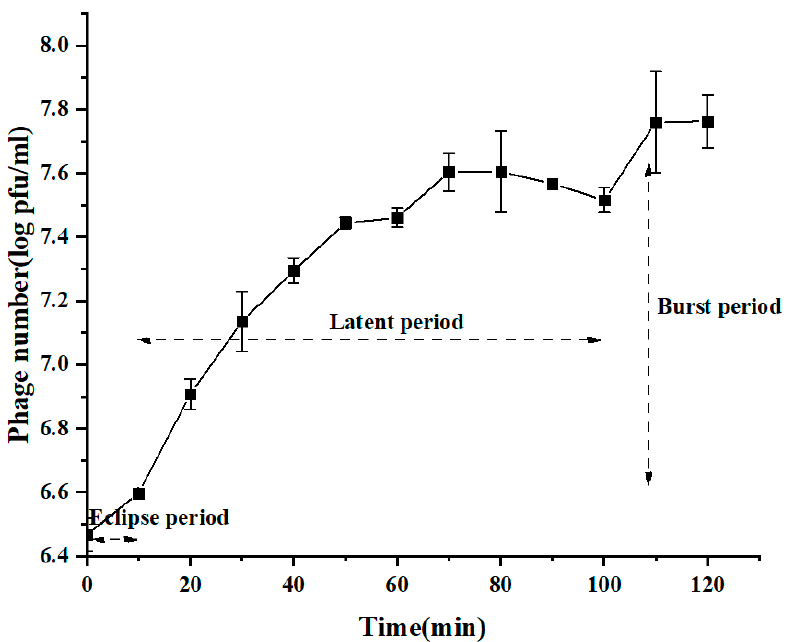
Figure 2. One-step growth curve of phage BG3P infecting its host strain ( C. perfringens BG3) at 37 °C. Latent and explosion periods are indicated. Values are the mean of three determinations.